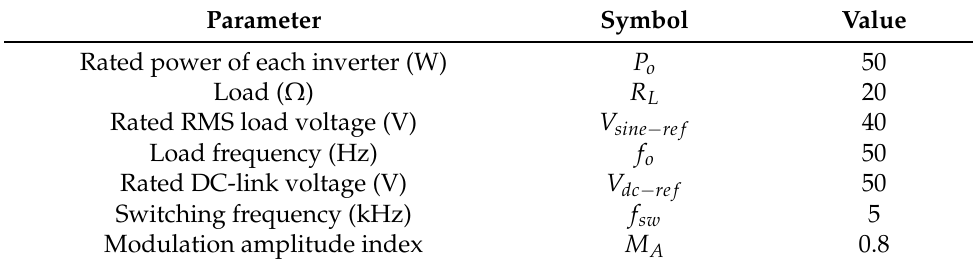
Table 6. Operating conditions (scaled-down) for the experimental